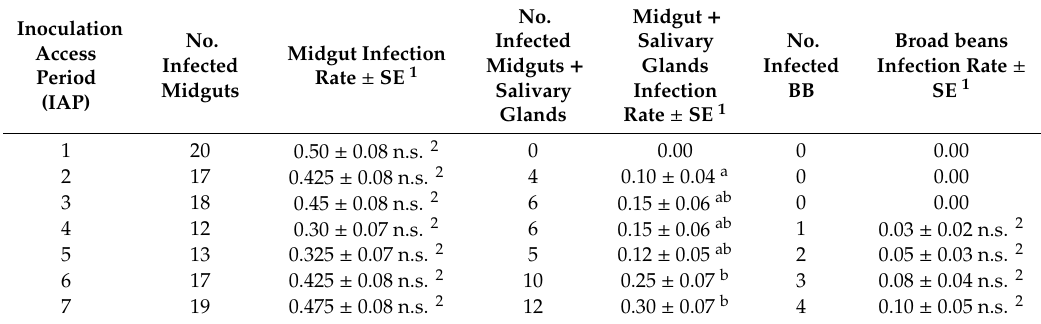
Table 1. Rate of flavescence dor è e phytoplasma infection in E. variegatus midgut and salivary glands after an acquisition access period at the adult stage, and in broad beans inoculated by single specimens. The number of infected samples for each group is indicated ( n = 40). Di ff erent letters indicate significantly di ff erent results according to generalized linear model (GLM) analysis ( p < 0.001).